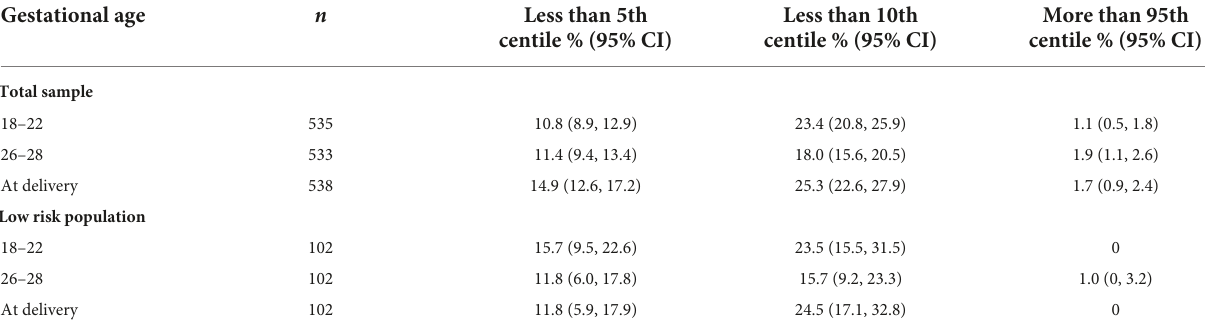
TABLE 4 Comparison of GWG in the REVAMP cohort and low risk population with the Intergrowth 21st